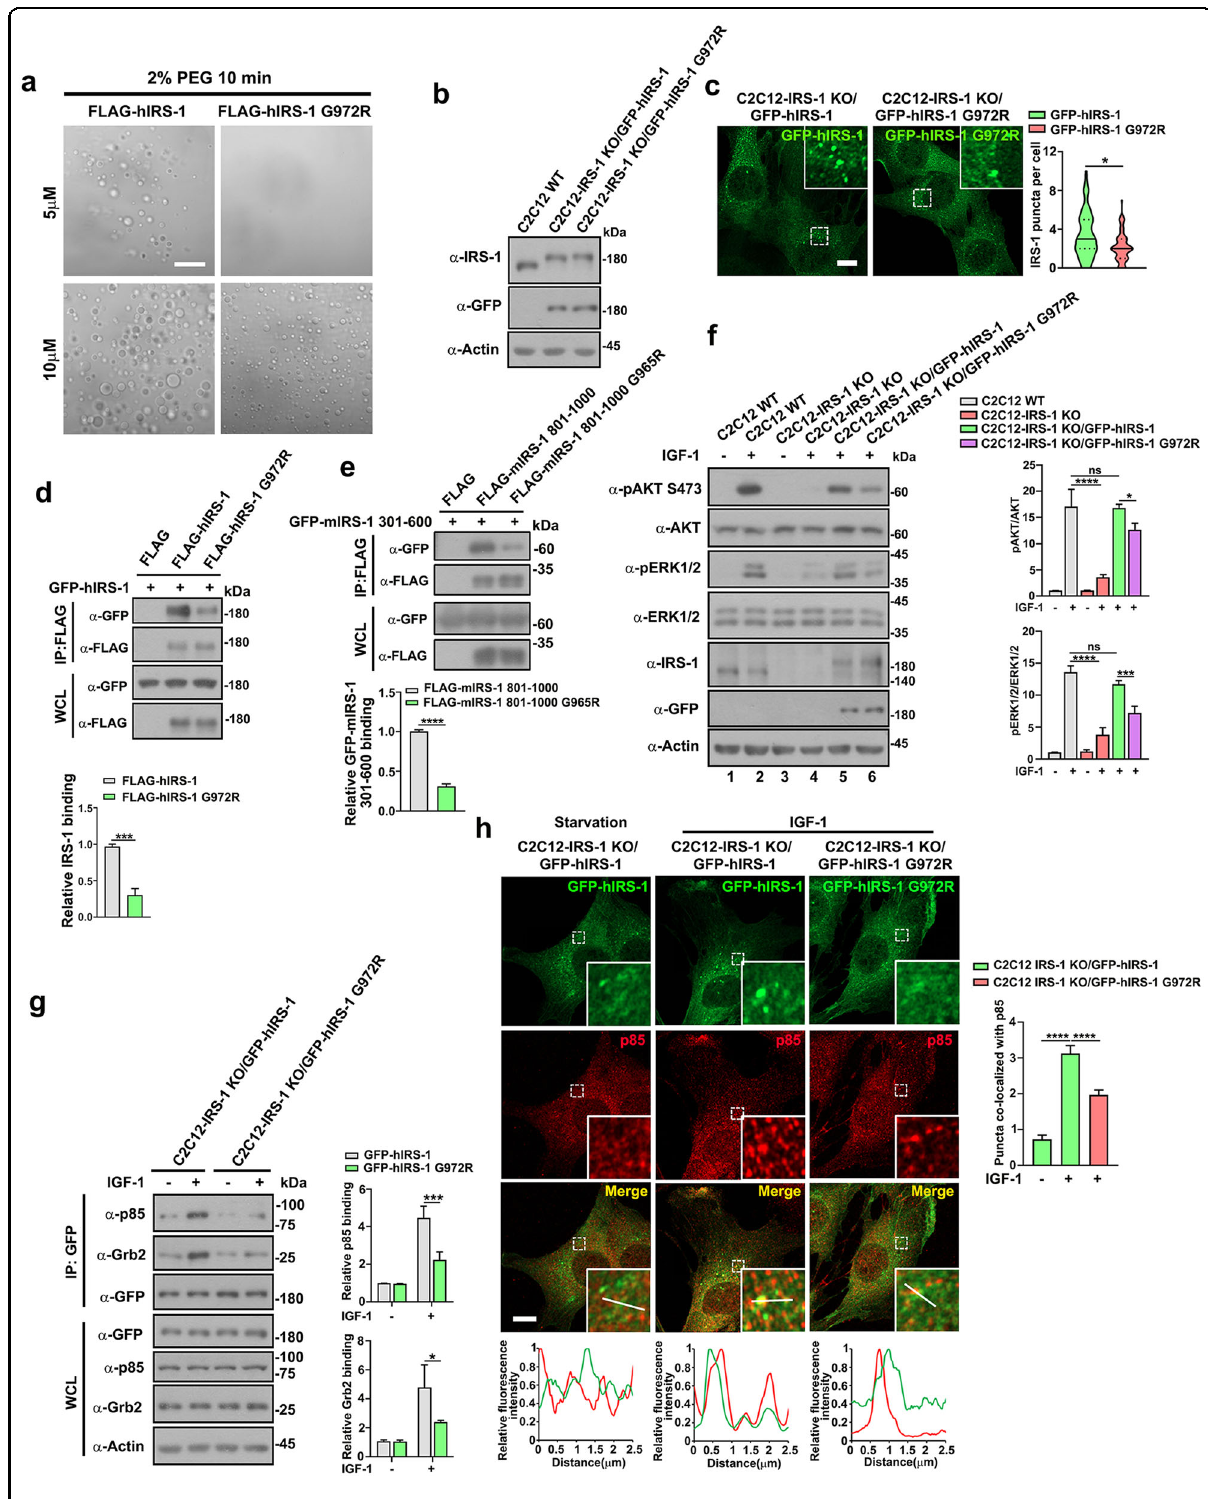
Fig. 6 (See legend on next